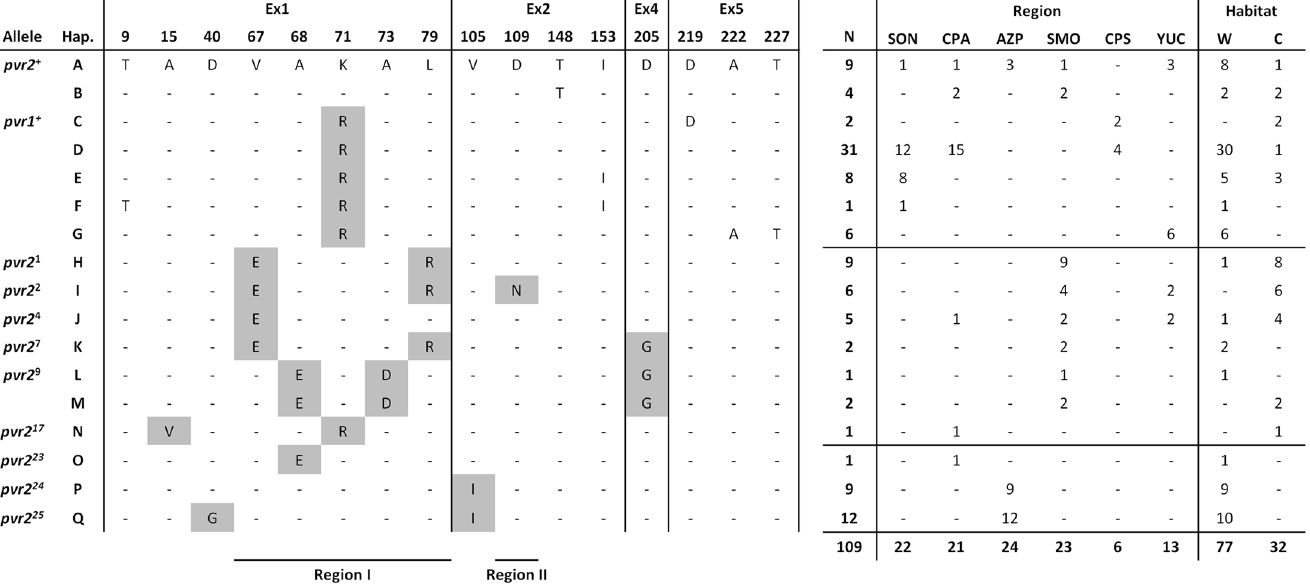
Fig 2. Amino acid polymorphisms in pvr2/eIF4E1 and pvr2/eIF4E1 allele frequencies in chiltepin populations according to biogeographical province and habitat. Ex1 to Ex5 indicate the protein domains encoded by exons 1 to 5 of pvr2/eIF4E1 , respectively. The different alleles and haplotypes at the nucleotide sequence level (Hap. A to Hap. Q) are indicated. N is the total number of sequences corresponding to each haplotype identified in chiltepin populations according to geographical provinces (SON: Sonora, CPA: Costa del Pacífico, CPS: Costa del Pacífico Sur, AZP: Altiplano Zacatecano-Potosino, SMO: Eastern side of the Sierra Madre Oriental, YUC: Yucatan) and habitats (W: wild, C: cultivated). Sequences are compared with that of pvr2 + , “ - ” indicates that the codon is identical to that of pvr2 + , the non highlighted letters identify codons where a synonymous substitution occurred, and the grey boxes highlight codons with non-synonymous substitutions. Regions I and II delimit the protein regions involved in Potyvirus resistance (as in